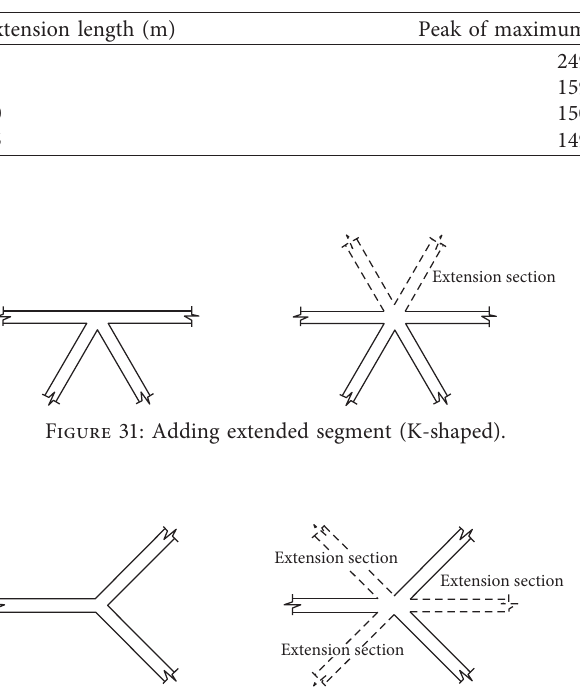
Table 20: Results of different extension lengths.